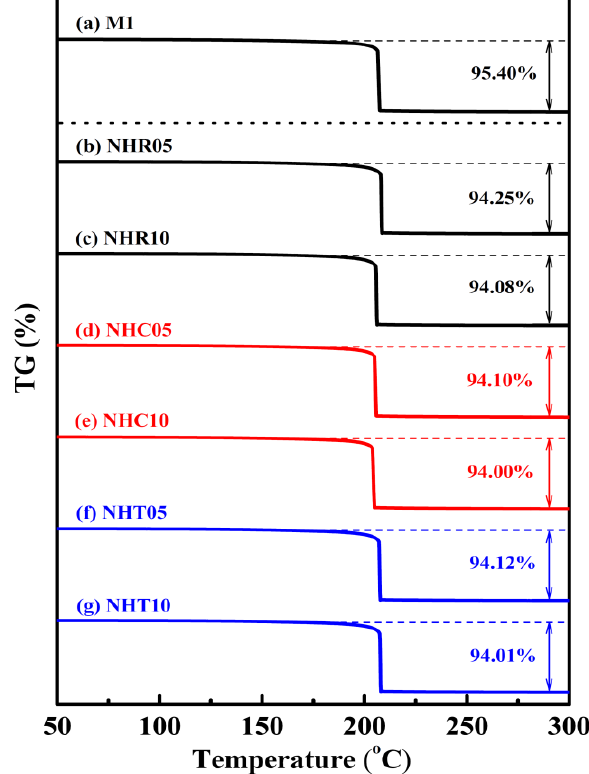
Figure 3. TGA curves of samples ( a ) M1, ( b ) NHR05, ( c ) NHR10, ( d ) NHC05, ( e ) NHC10, ( f ) NHT05, and ( g ) NHT10 at a heating rate of 10 °C min −1 .